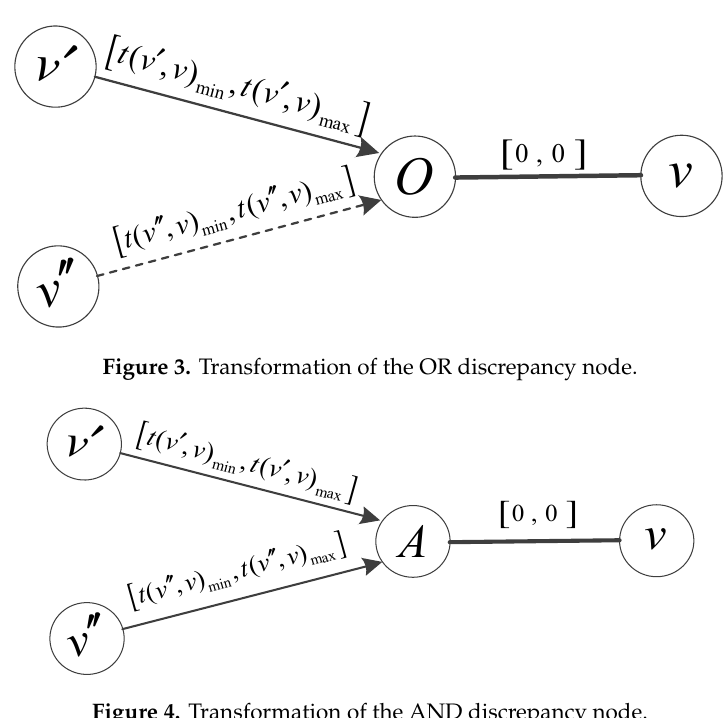
Figure 4. Transformation of the AND discrepancy node.